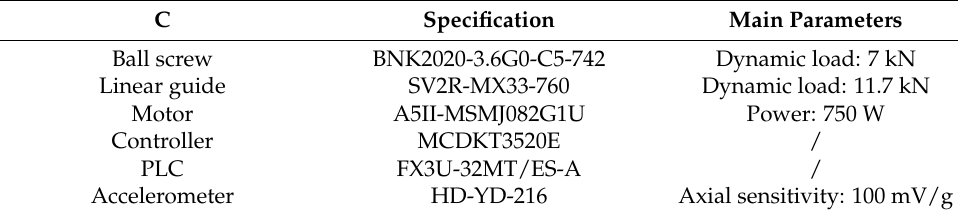
Table 6. Specification of the ball screw test platform.